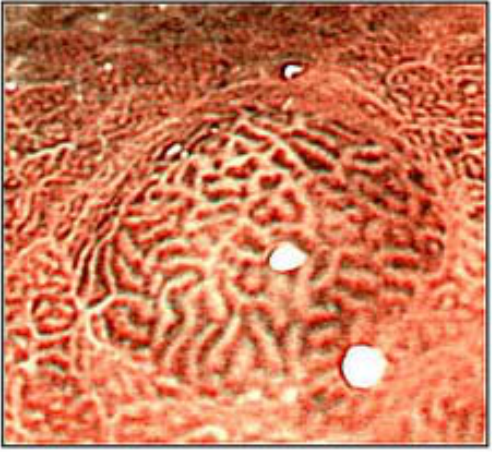
FIGURE 11. Stomach: Antral mucosa in the distal stomach; narrow-band imaging at low magnification. A slightly protruding island of intestinal metaplasia with large and sinuous crests is surrounded by the shorter epitelial crests of the antral